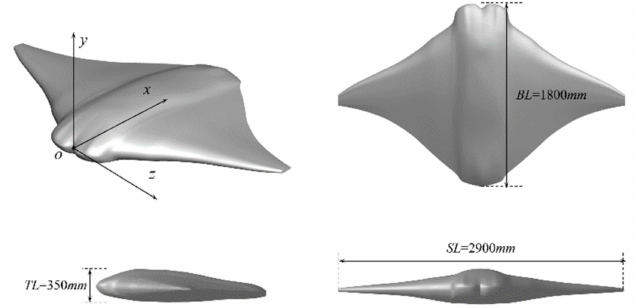
Figure 1. The 3D model of a manta